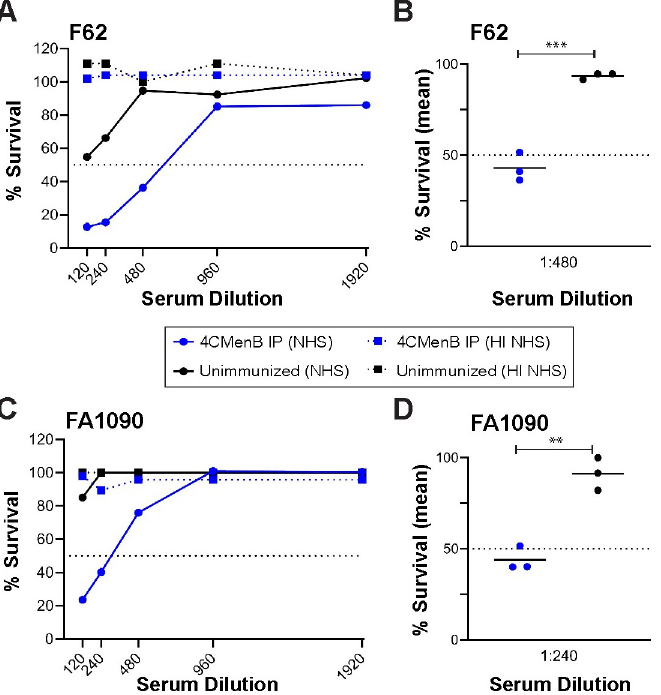
Fig 3. Pooled antiserum from 4CMenB-immunized mice is bactericidal against a serum-sensitive and a serum- resistant Ng strain. Serial dilutions of pooled serum from mice vaccinated with 250 μ l of 4CMenB (blue lines) or Alum alone (black lines) by the IP route were incubated with 10 4 CFU of the challenge strain F62 or strain FA1090 in microtiter plates as described in the Methods. After 5 min, NHS or heat-inactivated (HI)-NHS (final concentration, 10%) was added. After 55 min incubation at 37˚C, the number of viable Ng in each well was determined by duplicate culture on GC agar. (A, C) Recovery of F62 (A) or FA1090 (C) from each condition expressed as the number of CFU from wells incubated with test serum divided by the number recovered from wells containing PBS instead of test serum, X times 100. Solid lines indicate NHS was used as the complement source; dotted lines represent data from wells tested in parallel with HI-NHS. The dotted line at 50% survival was drawn to identify the bactericidal 50 titers. (B, D) Recovery of viable F62 (A) or FA1090 (B) from a 1:480 or 1:240 dilution of serum, respectively, from 4CMenB- immunized mice or unimmunized mice for each of three independent experiments, expressed as above. A significant difference was observed between the immunized and unimmunized serum ( �� , p < 0.01; ��� , p < 0.0001).